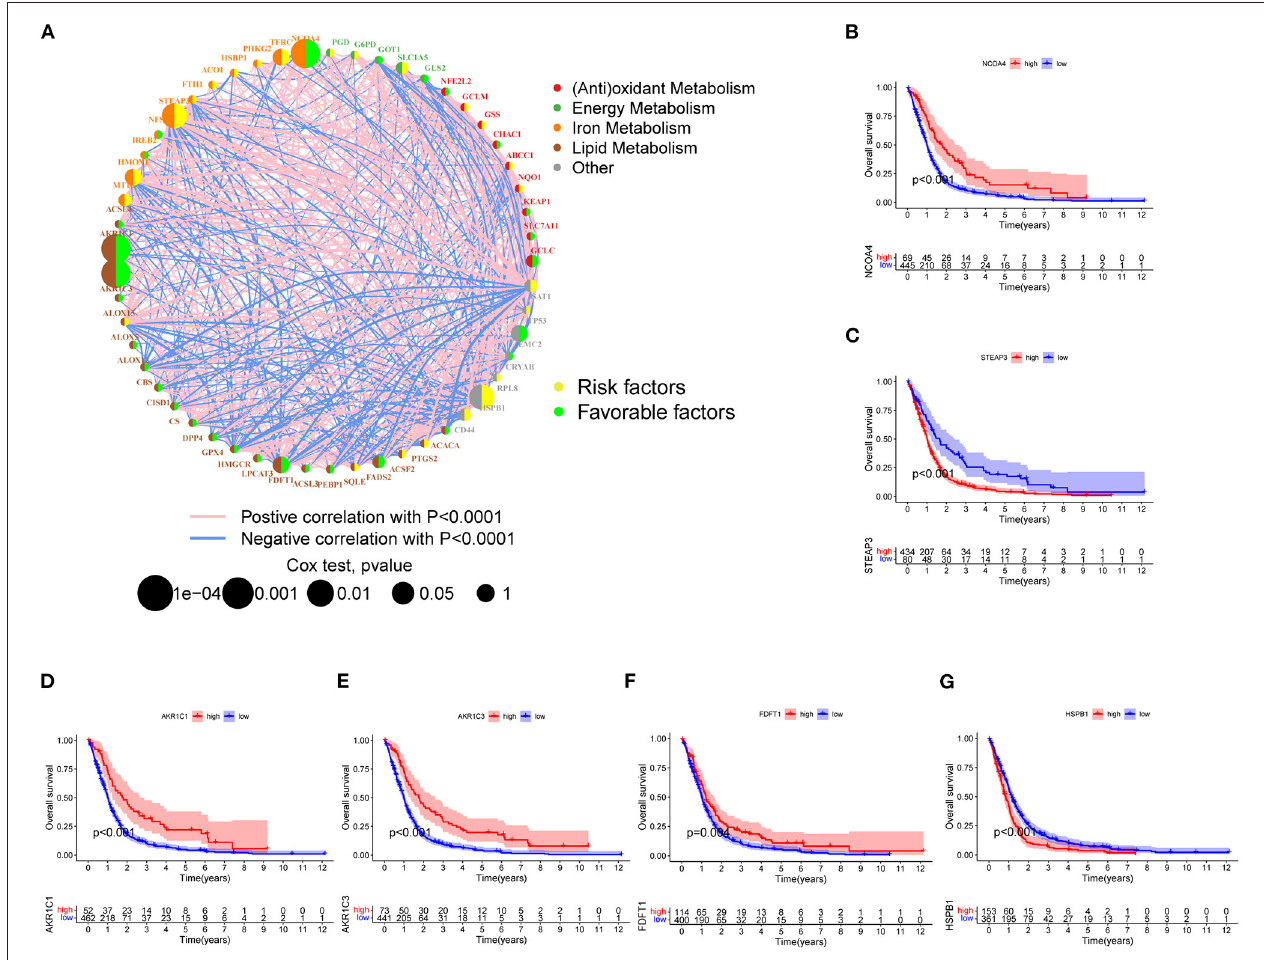
FIGURE 2 | FRGs associated with prognosis. (A) The degree distribution of the prognostic-related gene network. The yellow circles indicate high-risk genes, and the green circles indicate low-risk genes. The remaining five colored dots represent five types of FRGs. The blue line indicates a negative correlation, and the pink lines indicate positive correlations with correlation coefficients of p < 0.0001. Cox regression analysis (Cox p -value range 0.0001–1). The size of the dot reflects the p -value. (B–G) Six FRGs significantly associated with prognosis (NCOA4, STEAP3, AKR1C1, AKR1C3, and HSPB1 p < 0.001; FDFT1 p <